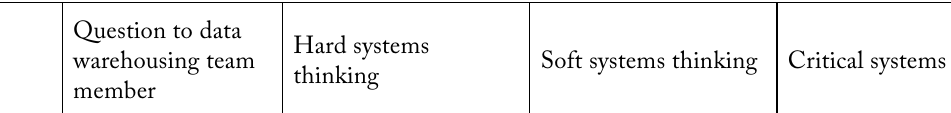
Table 2 Example from detailed mapping between systems thinking methodologies and data